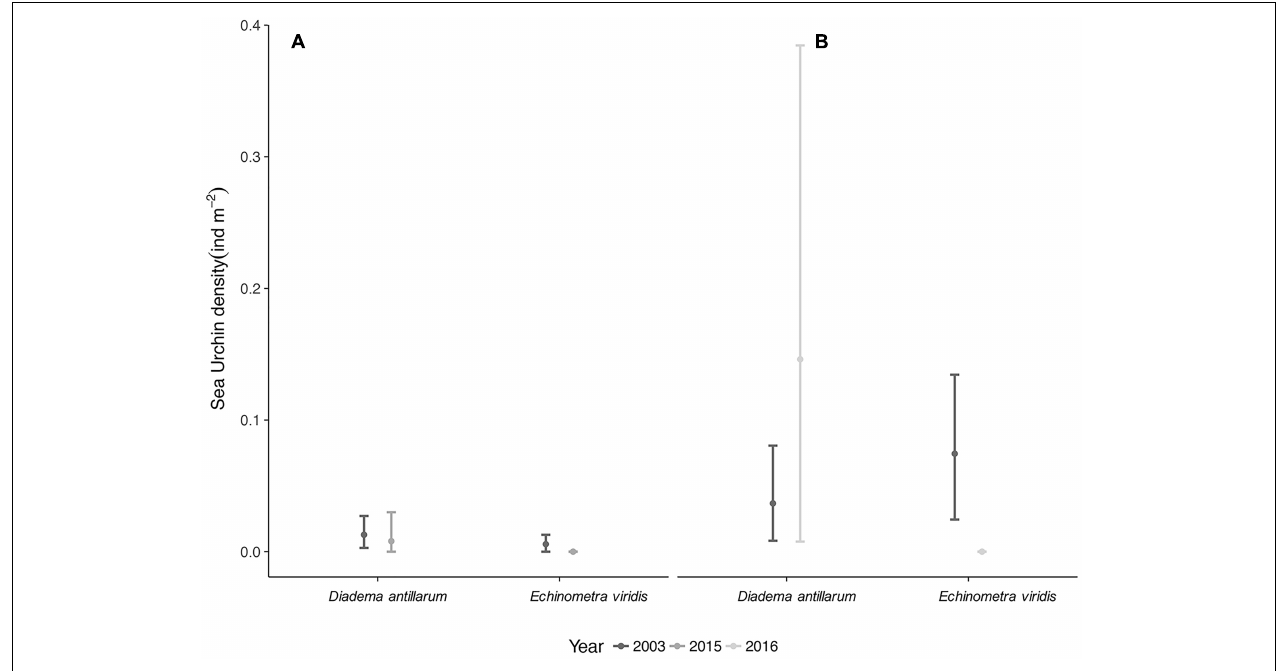
FIGURE 6 | Sea Urchin abundance. Species mean density (ind m - 2 ) with 95% CI for two periods at (A) Roncador 2003/2005 and (B) Serrana Banks 2003/2016.